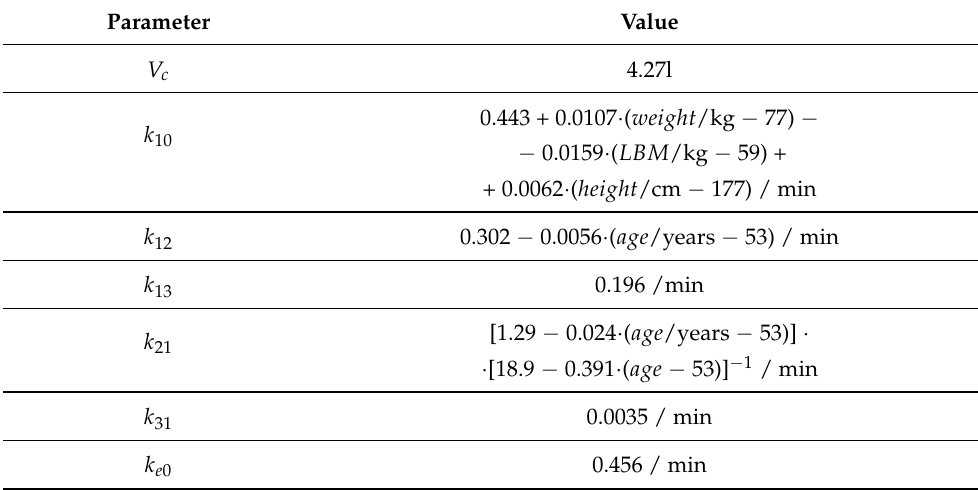
Table 1. Parameter values.